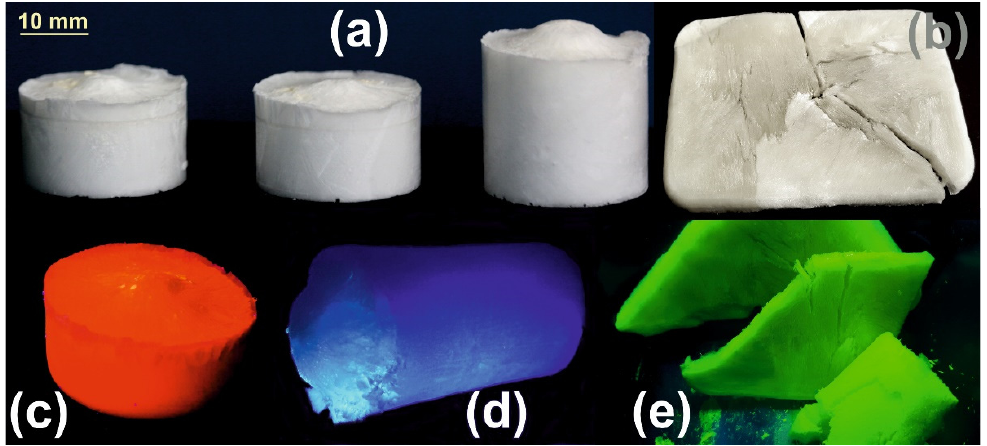
Figure 6. Prepared photoluminescent aerogels ( a ) Regular shape denser monolithic, ( b ) lower density fibrous configuration under ambient lighting, ( c ) Eu(III), ( d ) La(III) and ( e ) Tb(III) aerogels under 370 nm UV excitation.